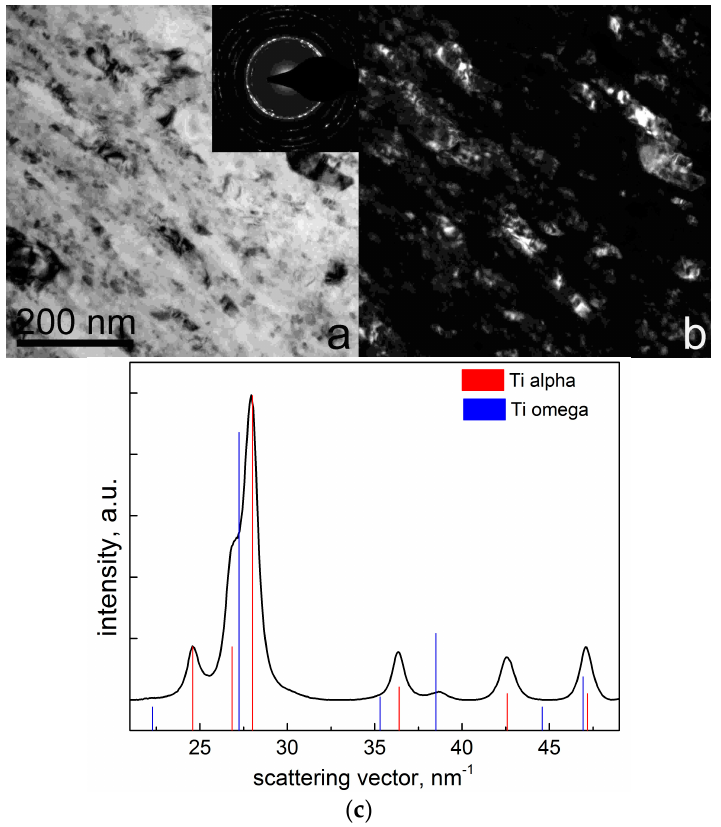
Figure 1. Transmission electron micrograph and electron diffraction pattern of the Ti–2 wt % Co as-cast alloy subjected to HPT at 7 GPa, 1 rpm, and five rotations: ( a ) bright field image with inset (upper right corner) showing the selected area electron diffraction pattern; ( b ) dark field image; and ( c ) radial intensity distribution respective to the diffraction pattern. Intensities were integrated along the Debye rings. Red bar charts show the positions of the reflections from α -Ti. Blue bar charts show the positions of the reflections from ω -Ti.